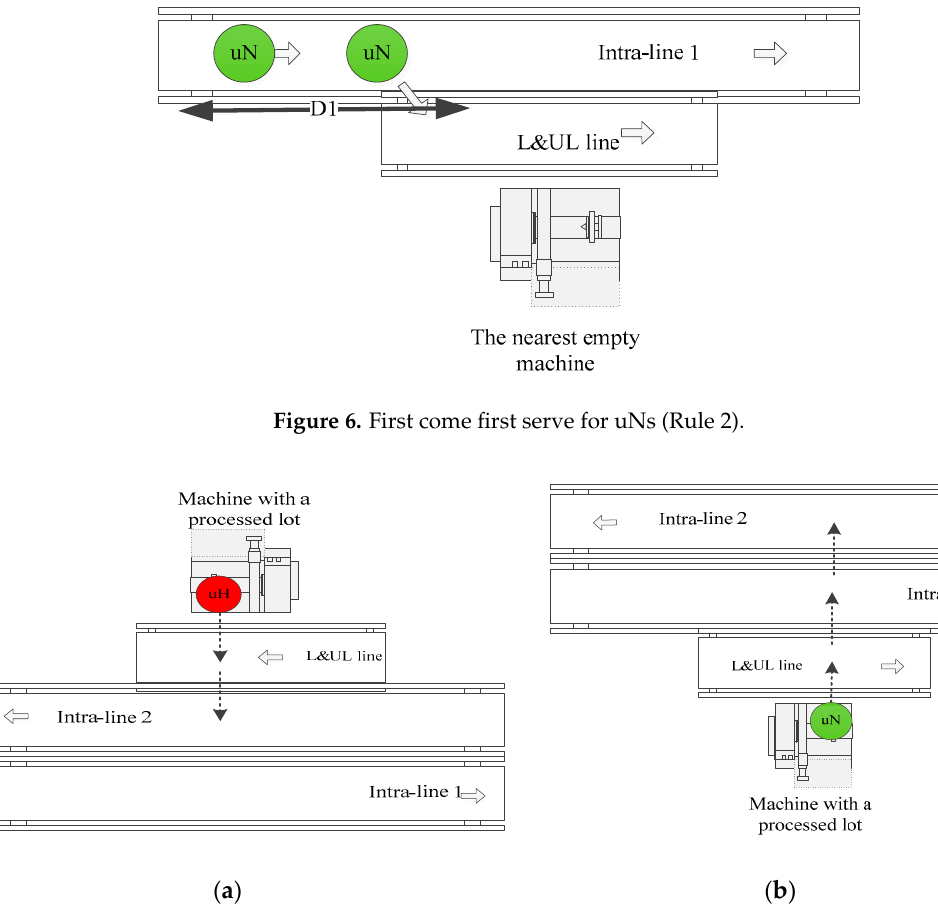
Figure 7. ( a ) Directly move a pL to Intra-Line 2 ( b ) first move a pL to Intra-Line 1 and then to Intra-Line 2 (Rule 3).